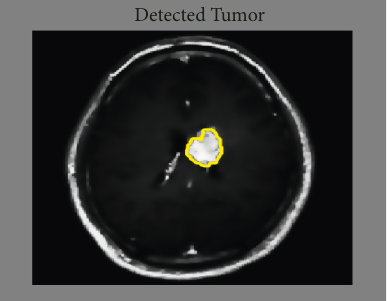
Figure 18: Exact brain tumor detection output after superimposition.